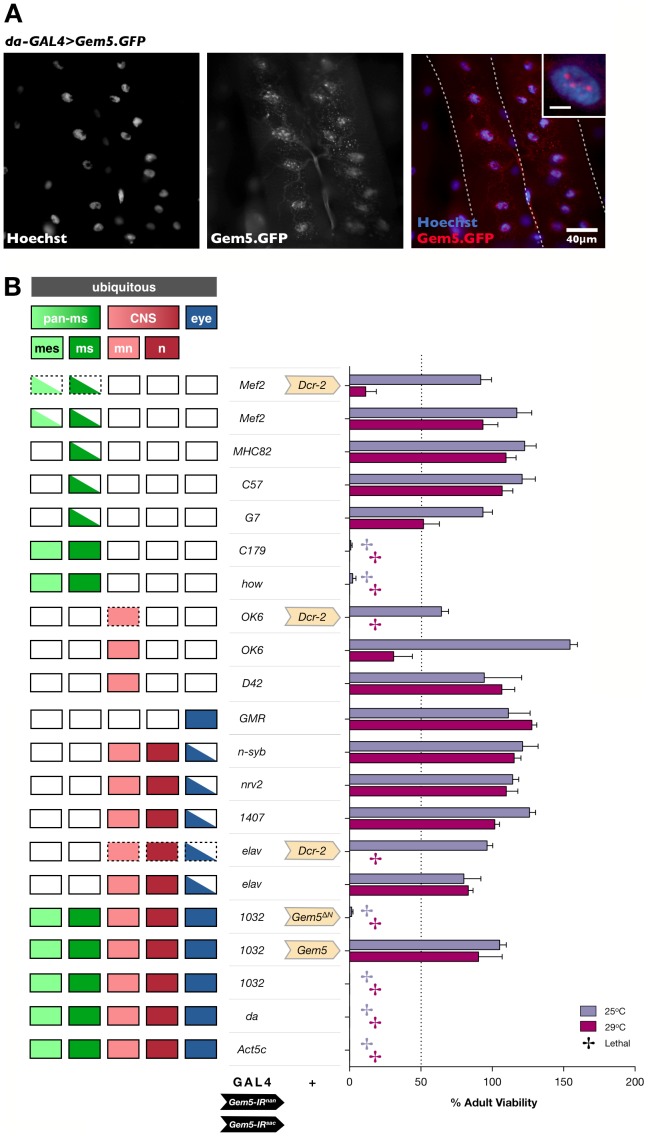
Gemin5 concentrates in predominantly nuclear foci and adequate levels in muscle as well as neurons are required for viability.(A) Larval muscles (delineated by dashed white outline) of flies ubiquitously expressing a GFP-tagged Gemin5 functional fusion protein. Gemin5 concentrates in puncta of variable size that are predominantly nuclear (insert, scale bar = 5 µm). For reasons as yet unclear, GFP is also detected within the tracheal system that supplies the muscles with oxygen. (B) A severe Gemin5 knockdown through the concomitant expression of two RNAi transgenes (Gem5-IRnan+Gem5-IRsac) targeting Gemin5 mRNA transcripts causes lethality when their expression is driven ubiquitously via the 1032-GAL4, da-GAL4 or Act5c-GAL4 drivers. RNAi is specific since the co-expression of a full-length Gemin5 transgene (Gem5) but not a truncated version lacking its N-terminus (Gem5
ΔN) restores viability. Ubiquitous-associated lethality can be replicated if Gemin5 depletion is restricted to muscle lineages via the C179-GAL4 or how-GAL4 driver. A drastic reduction in viability can be observed when RNAi is driven via the pan-muscular Mef2-GAL4 driver at a temperature of 29°C and in the presence of enhanced Dicer-2 levels, both strategies employed to heighten the knockdown effect. Reduced levels of Gemin5 within the somatic musculature via the G7-GAL4 driver also had a marked negative impact on adult viability. A lethal outcome could also be obtained when RNAi is constrained to all CNS neurons (elav-GAL4) or exclusively to motor neurons (OK6-GAL4) at a temperature of 29°C and on upregulation of Dicer-2. Compared to controls, enhanced knockdown of Gemin5 in the eyes via the GMR-GAL4 driver does not lead to a rough eye phenotype (data not shown). Note that, as expected, not all drivers with a similar tissue expression pattern (left panel) give an analogous result with one reason being that they might not drive strong GAL4 levels comparable to their effective counterparts. Bar chart (right panel) shows adult fly viability assayed at 25°C and 29°C. Individual bars represent the mean viability ± S.E.M. of at least 4 independent experiments. Abbreviations: pan-ms, pan-muscular; mes, mesoderm; ms, larval muscles; mn, motor neurons; n, all CNS neurons except motor neurons.